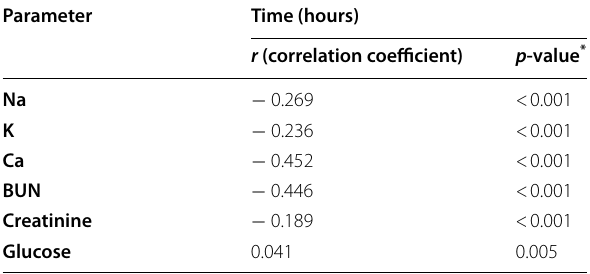
Abbreviations : BUN blood urea nitrogen, Ca calcium, K potassium, Na sodium